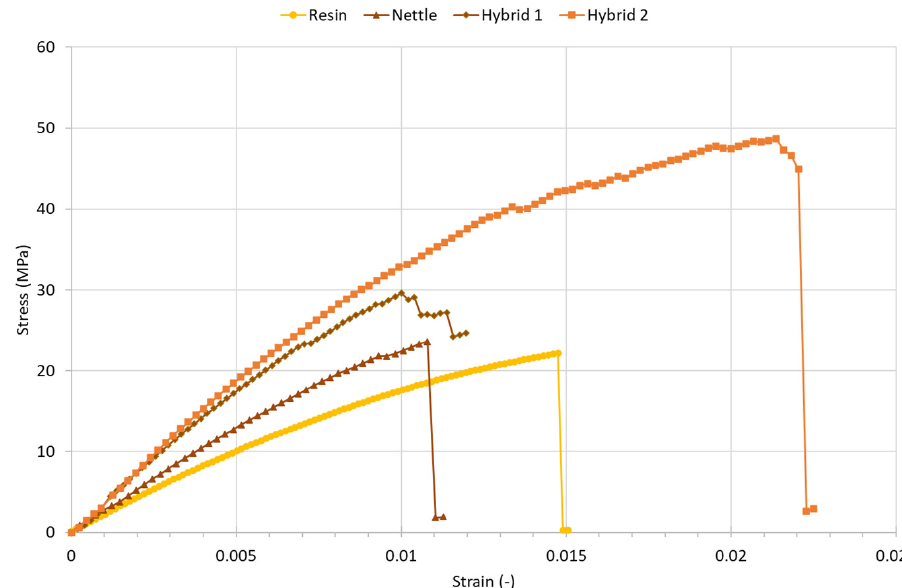
Figure 3. Typical tensile stress versus strain curves.